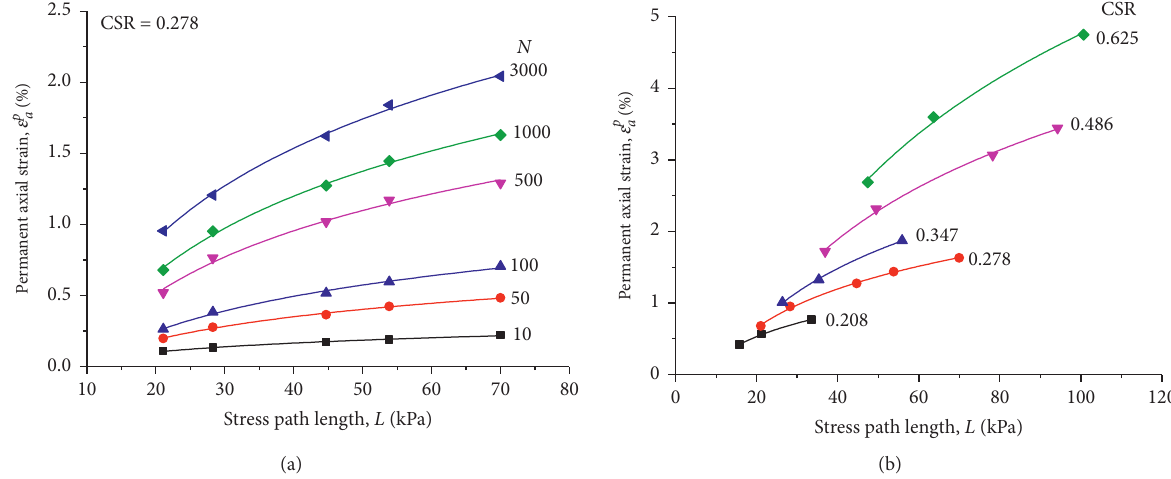
Figure 9: Permanent axial strain after 1000 cycles versus the length of stress path. (a) CSR � 0.278.